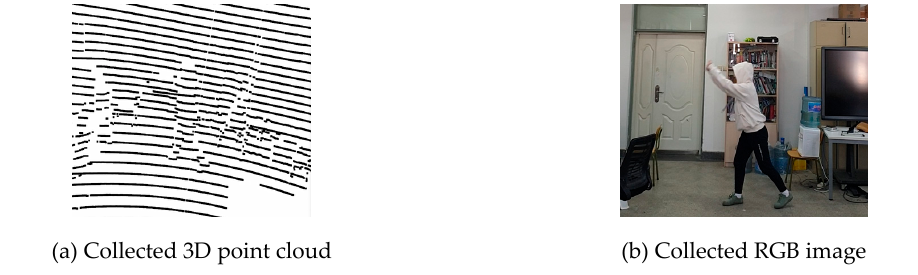
Figure 7. 3D point cloud and an RGB image measured using a LiDAR and an RGB camera.